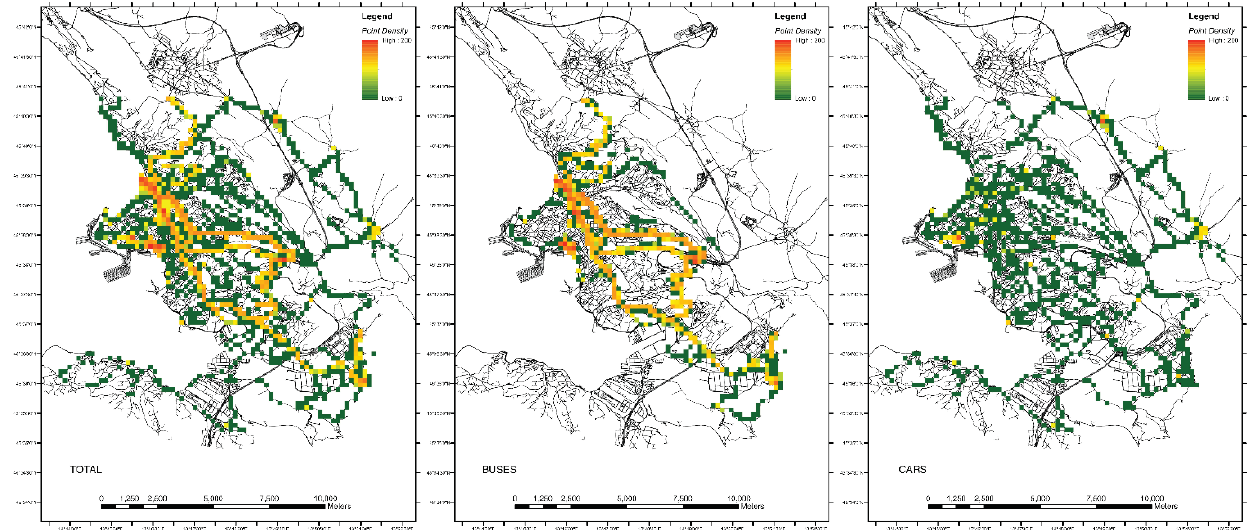
Figure 4. Maps of point density in the designated area calculated using the (TOTAL) full dataset, the (BUSES) buses-only dataset, and the (CARS) cars-only dataset.